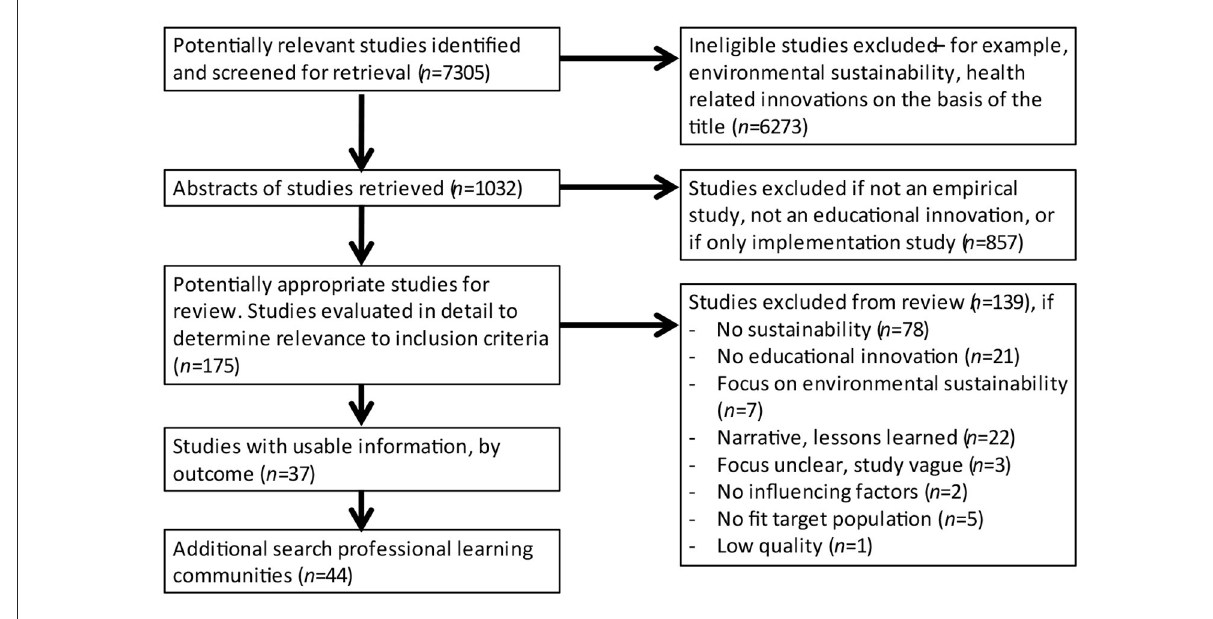
FIGURE1 Flowchart quorum selection